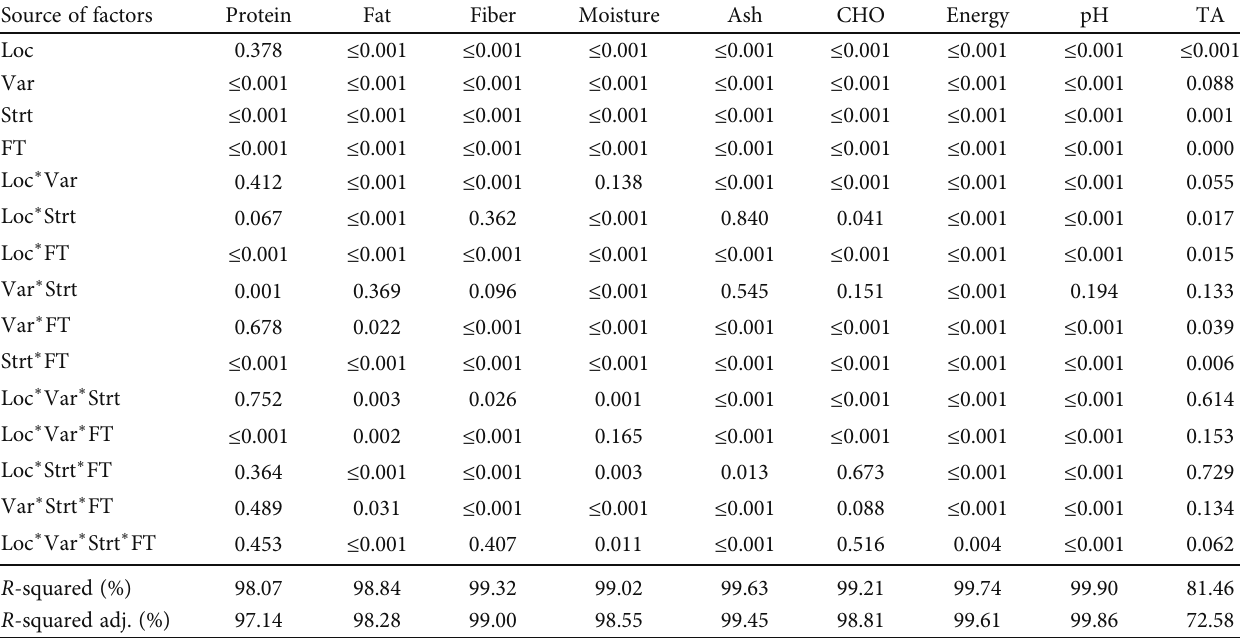
Table 2: ANOVA results ( p values) for the proximate and physicochemical composition of kocho. Source of